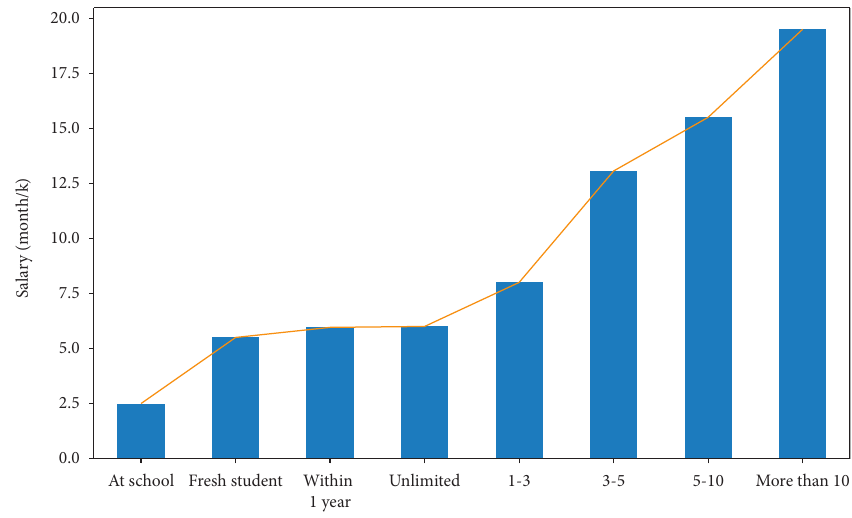
Figure 3: Salary of different educations.